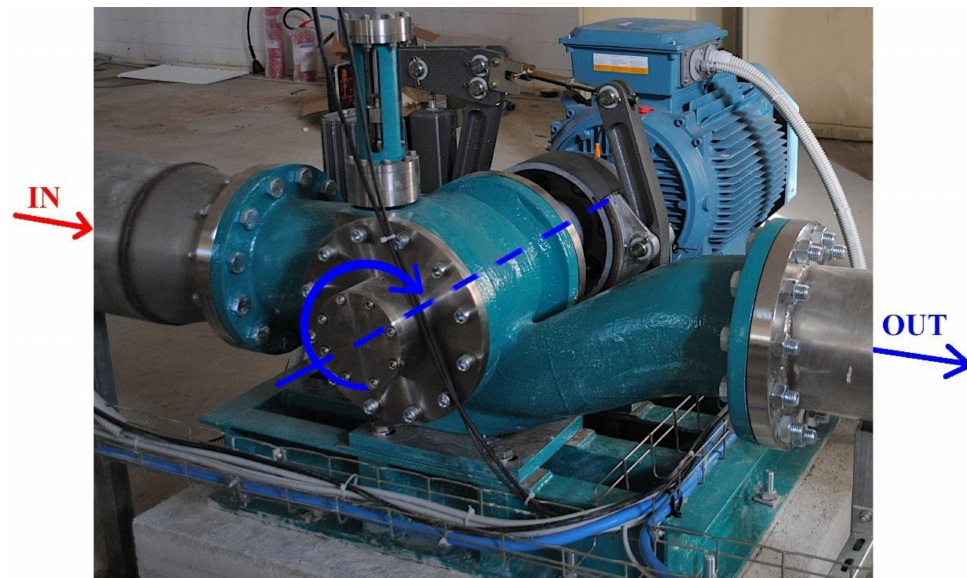
Figure 15. PRS turbine of the case study.